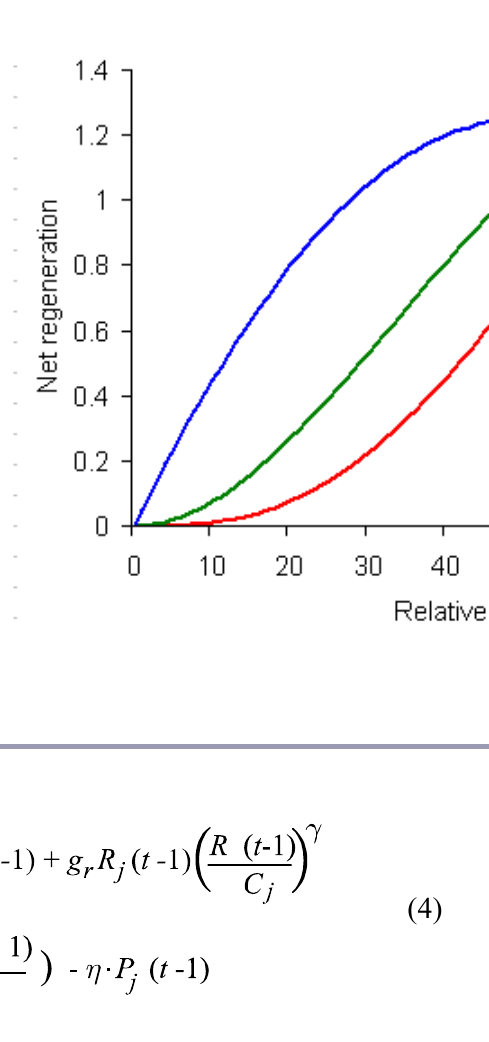
Fig. 3. Net growth curves, Rj ( t +1) – Rj(t) , for different assumptions of depletion rate and recovery rate of the resource levels in each cell. For irreversible, we assume = 2 and gr = 0.1188; for hysteresis, we